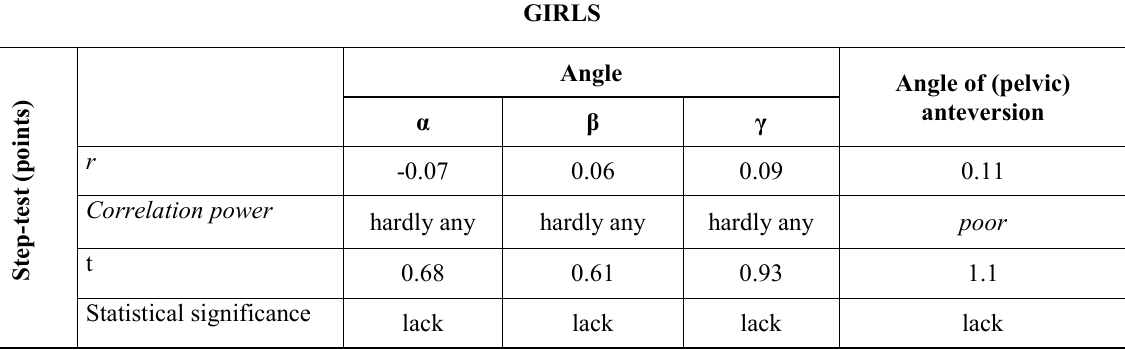
Correlations occurring between the angles characteristic of anterior-posterior pelvic tilts (upper thoracic - α, thoracic- lumbar - β, sacral-lumbar γ) and the angle of pelvic anteversion in the sagittal plane and the number of points scored in the step test in the boys involved in the